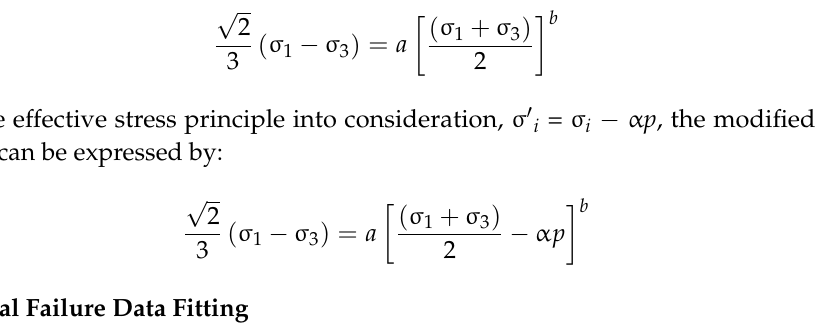
Figure 11. Measured strength data and curves fitted using the Drucker-Prager criterion.